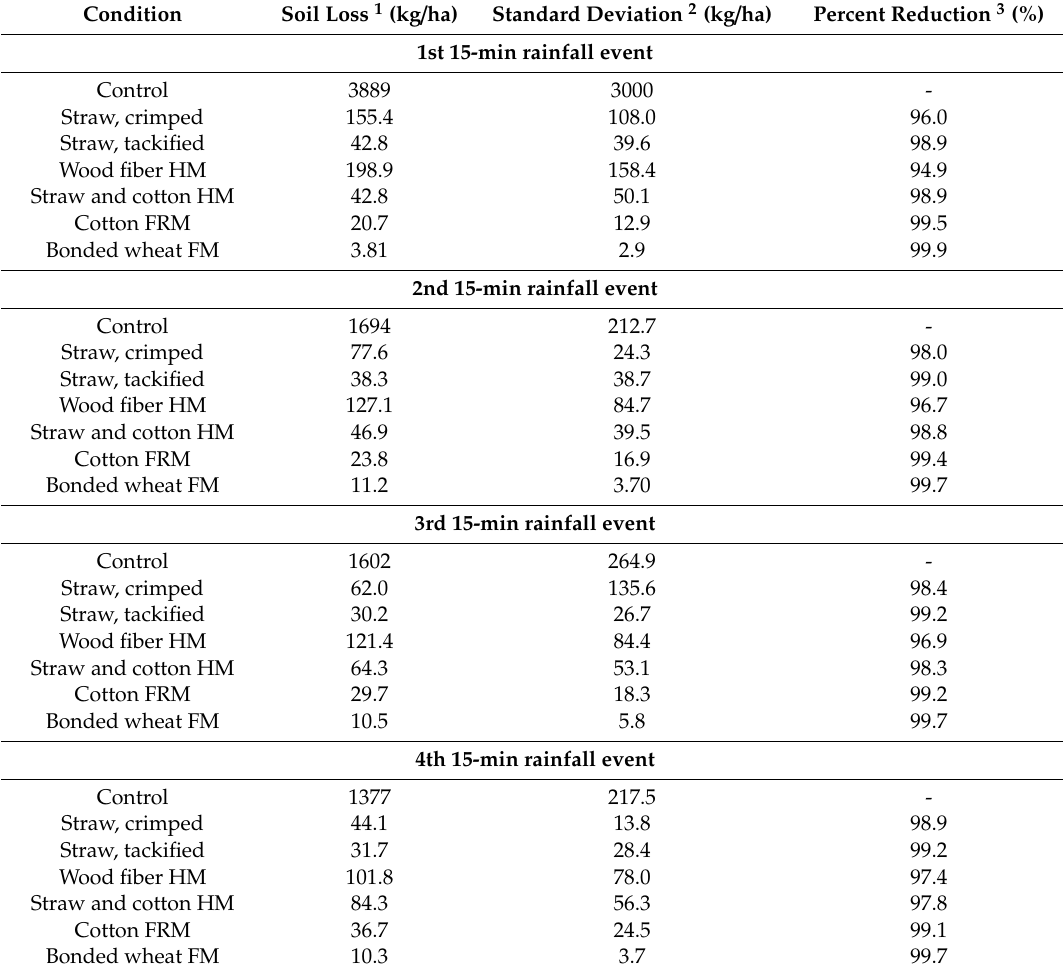
Table 5. Average soil loss over each 15-min rainfall event due to surface runo ff . Condition Soil Loss 1 (kg / ha) Standard Deviation 2 (kg /